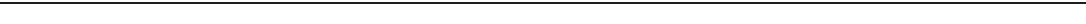
Fig. 6 Expression of mutant HRAS Q61R results in the acquisition of a partial myoepithelial phenotype in non-malignant breast epithelial cells. a Representative western blot (left) analysis of total protein expression of alpha-smooth muscle actin ( α SMA), TIMP1, cytokeratin 5 (CK5), E-cadherin, vimentin, and nuclear protein expression of Δ N-p63 and TA-p63 in MCF-10A P , MCF-10A H1047R , and MCF-12A cells stably expressing empty vector (EV), HRAS WT , or mutant HRAS Q61R . α -Tubulin and Histone H3 were used as protein loading controls for total and nuclear protein expression, respectively. Quanti fi cation (right) using LI-COR is shown based on experiments done in triplicate. Comparisons of protein levels were performed between HRAS WT and mutant HRAS Q61R , both relative to EV. Error bars, s.d. of mean ( n = 3). n.s. = not signi fi cant, * P < 0.05, ** P < 0.01, *** P < 0.001, **** P < 0.0001; two-tailed unpaired t -test. b Representative micrographs of cells cultured in three-dimensional basement membrane for 10 days showing the effects of EV, HRAS WT , or mutant HRAS Q61R expression in MCF-10A P , MCF-10A H1047R , and MCF-12A cells on growth and glandular architecture (scale bars, 400 µ m). c Representative micrographs of E-cadherin, vimentin, and calponin immunohistochemical expression in a HRAS and PIK3CA mutant adenomyoepithelioma (AM32). Note the bi-layered glandular architecture where E-cadherin is preferentially expressed in the inner epithelial layer, whereas vimentin and calponin decorate the outer myoepithelial layer (scale bars, 50 µ m). d , e Representative confocal images of immuno fl uorescence analysis of d E-cadherin (green) and vimentin (red) and 4,6-diamidino-2-phenylindole (DAPI, blue; scale bars, 25 µ m), and e calponin (green) and DAPI (blue; scale bars, 50 µ m) of MCF-10A P , MCF-10A H1047R , and MCF-12A cells stably expressing EV, HRAS WT , or mutant HRAS Q61R grown in three-dimensional basement membrane culture for 10 days. In b , d and e , experiments were independently performed at least three